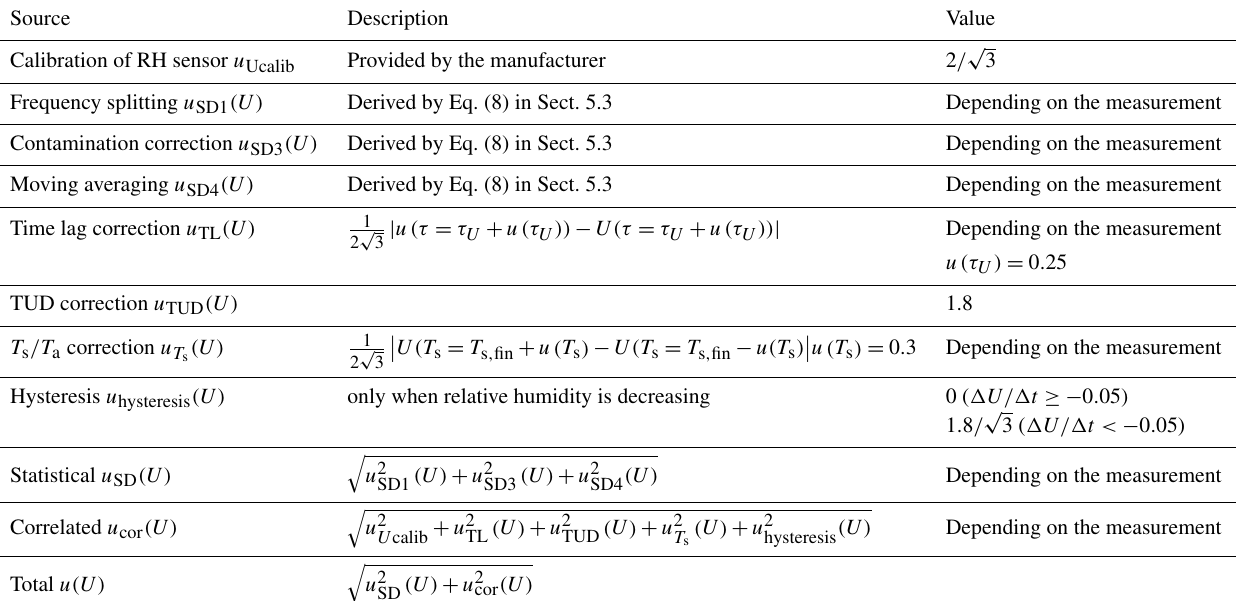
Table 7. Sources contributing to RS-11G RH measurement uncertainty. Uncertainties for frequency splitting, contamination correction, and moving averaging are associated with the use of filtering or moving averaging, which are determined by using the standard deviation of the correction amounts. TUD denotes temperature–humidity